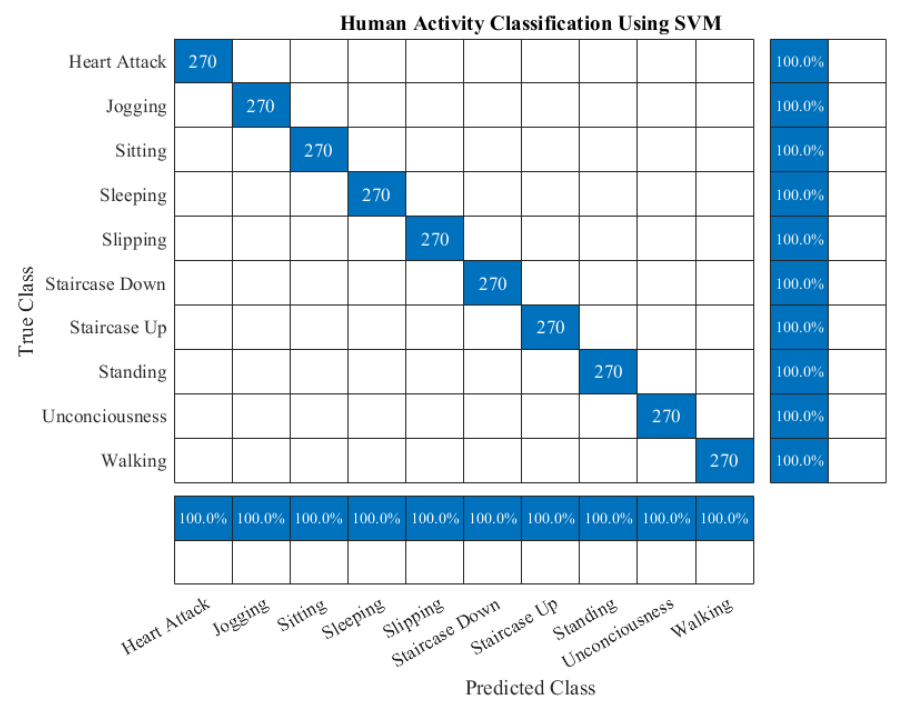
Figure 11. Confusion matrix of the proposed model on DU-MD dataset for the five best features.